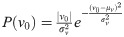
Distributions of small-scale parameters support generalized SPP.(A) Distribution of mouse fibroblast instantaneous speeds calculated from cell nuclei center-of-mass displacement between image capture events (blue). The red line is a fit to the form P(v0)=|v0|σv2e-(v0-μv)2σv2, which is the distribution of speeds expected for a Gaussian distribution of velocities. (B) Distribution of turning angles of mouse fibroblast trajectories (blue), SPP models with constant Dr (green), Gaussian distributed Dr (red), and a run-and-tumble model with Gaussian distributed Dr during runs and exponentially distributed tumbling events. The distribution of rotational diffusion constants is the same in both heterogeneous cases to highlight the effect of incorporating tumbling events into the system. (C) Run-time distribution for mouse fibroblast cells (blue) is well fit by an exponential distribution (red).